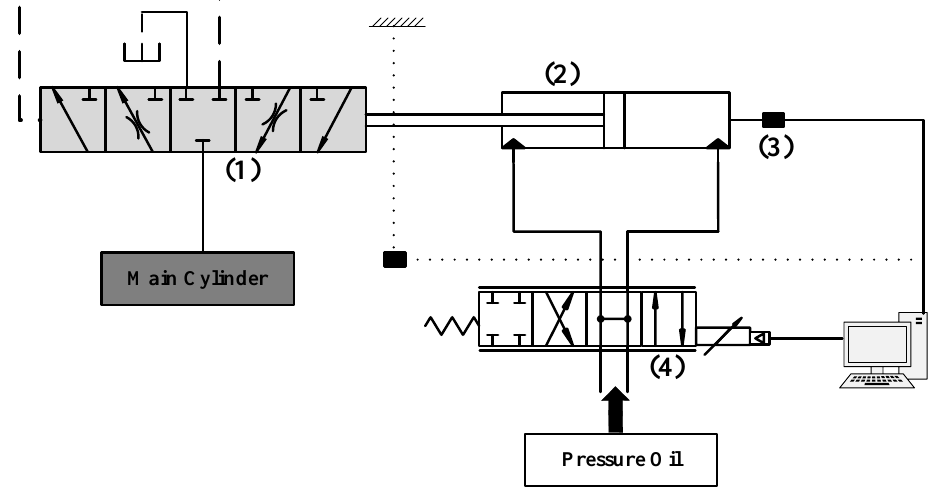
Figure 3. Schematic diagram of the electro-hydraulic servo control system. (1: main control valve; 2: servo hydraulic cylinder; 3: displacement sensor; 4: servo valve).